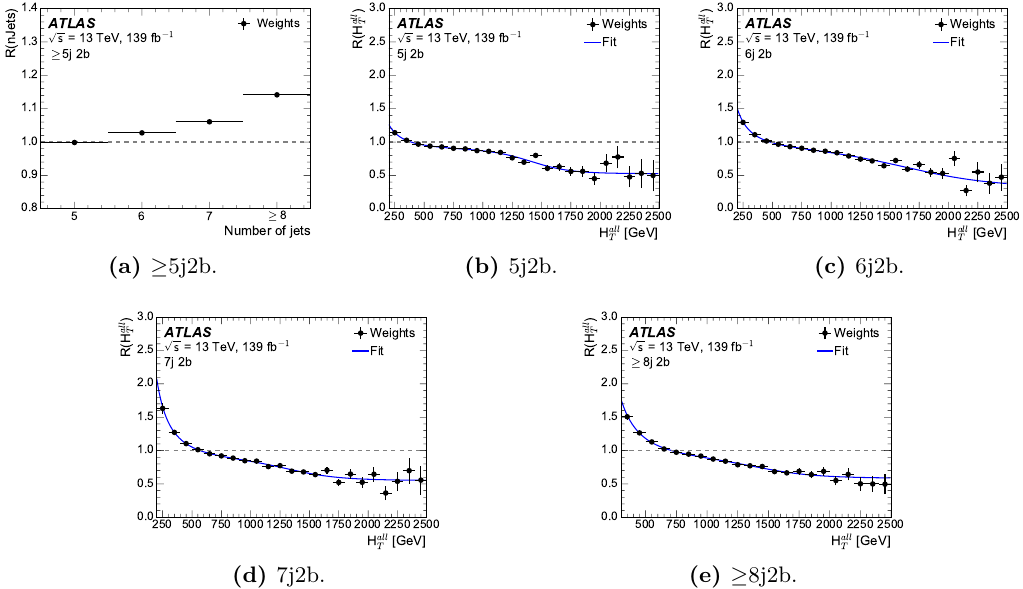
Figure 2 . Reweighting factors (weights) obtained from the comparison between data and simula- tion of the number of jets (a) and H all for various jet multiplicity selections (b) to (e). The errors T in the data points include the statistical uncertainties in data and MC